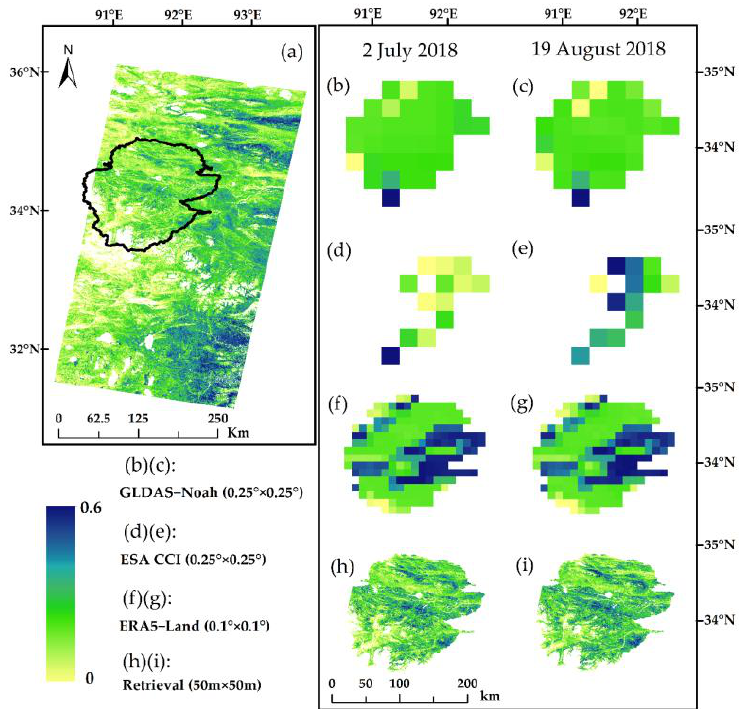
Figure 12. The comparison of SM distribution between retrieved SM and widely used SM products. ( a ) The place circled by the black line indicates the location of the Tuotuo River basin. ( b – i ): The SM distribution in this region with different data. The white areas in the retrieval results are caused by post-processing, where water bodies, mountain shadows, and regions with negative ∆ σ are masked. The white areas of SM products are caused by the lack of effective data in QTP.